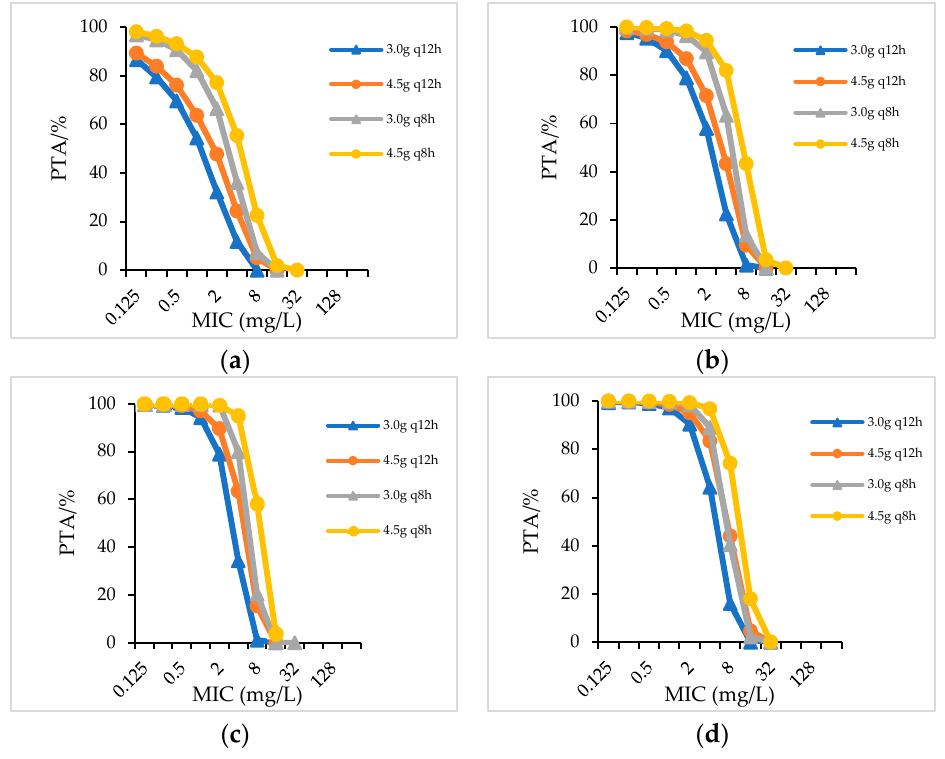
Figure 3. PTA for CSL in patients with different renal functions. ( a ) CrCL > 60 mL/min; ( b ) CrCL 31–60 mL/min; ( c ) CrCL 10–30 mL/min; ( d ) CrCL < 10 mL/min.